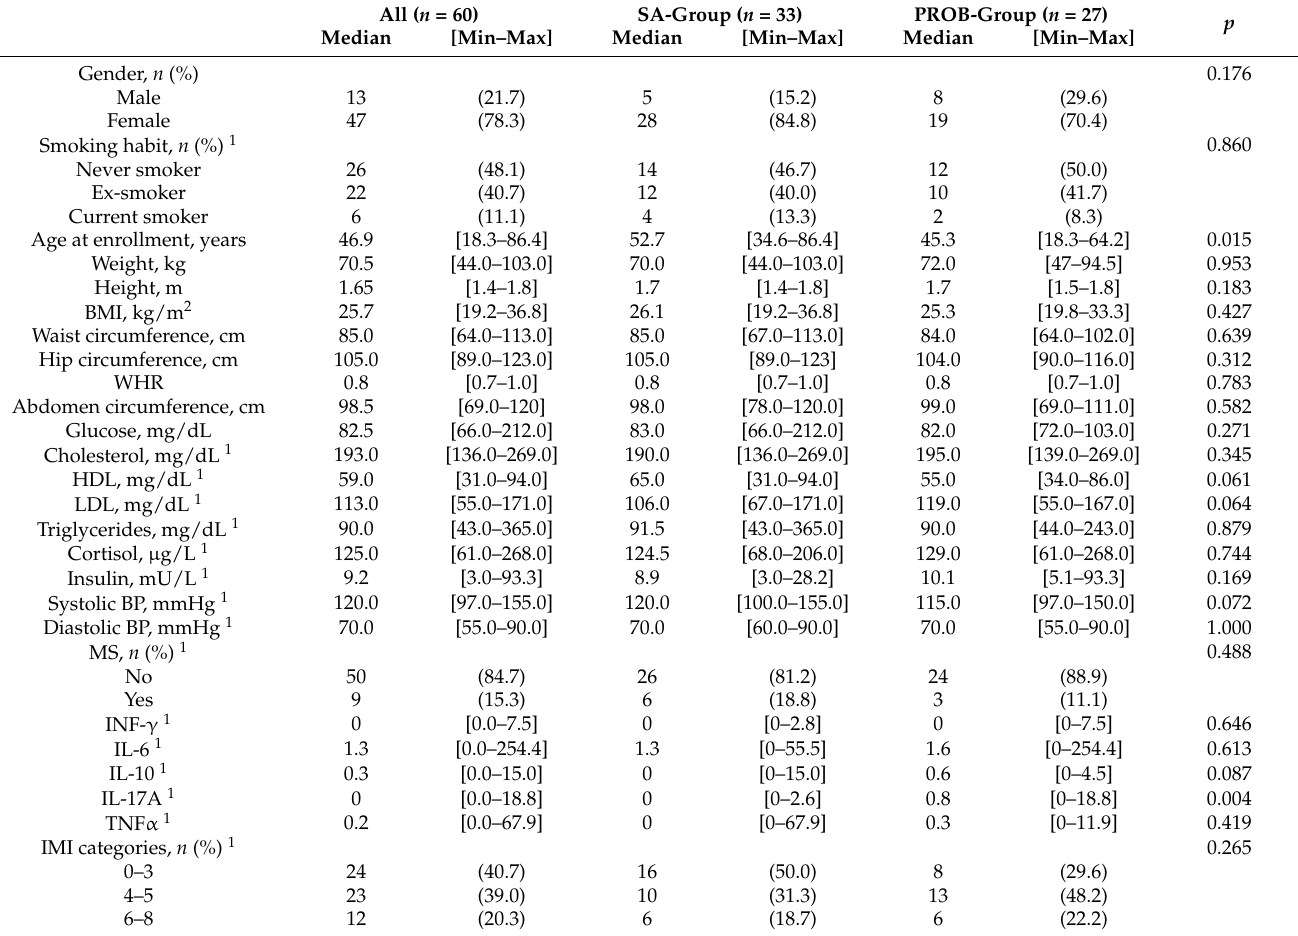
Table 1. Distribution at baseline of anthropometric, biochemical, and immunological characteristics for all study participants and separately for the dietary intervention groups. Italy,